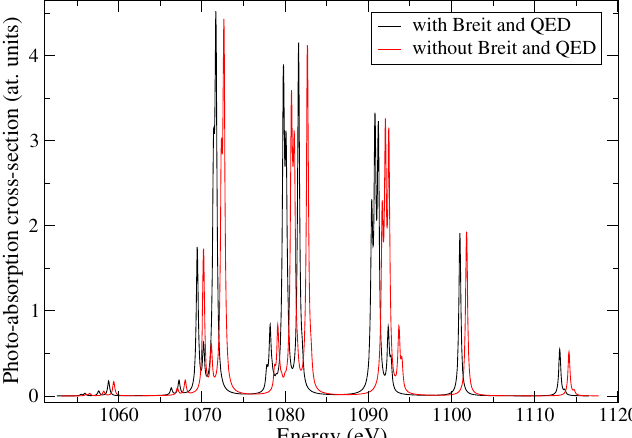
Figure 23. Iron [Be] 2 p 5 − 2 p 4 4 d structures of iron with and without Breit interaction and QED corrections. The calculations are perfomed with our MCDF code [90,91]. SCO-RCG is quasi-relativistic and has no account for QED. Breit interaction is accounted for only